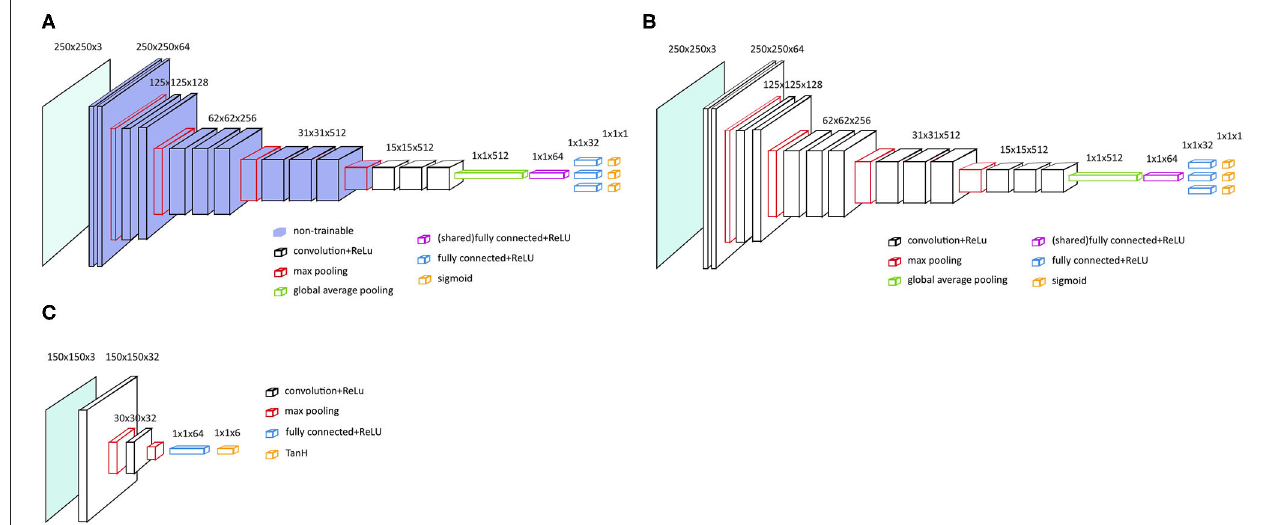
FIGURE 2 | Main architecture of the VGG-16 models. (A) VGG-16 model with frozen and pre-trained layers, i.e., VGG-16P and VGG-16PS. (B) VGG-16 architecture with no frozen layers and no pre-trained layers, i.e. VGG-16N and VGG-16NS. (C) Localization network with two convolutional layers, as applied for VGG-16PS and